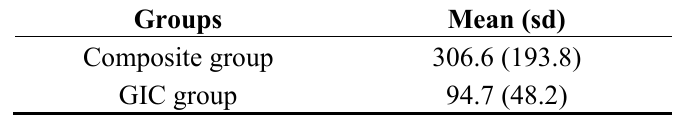
Table 1. Mean failure loads (standard deviation) in N.